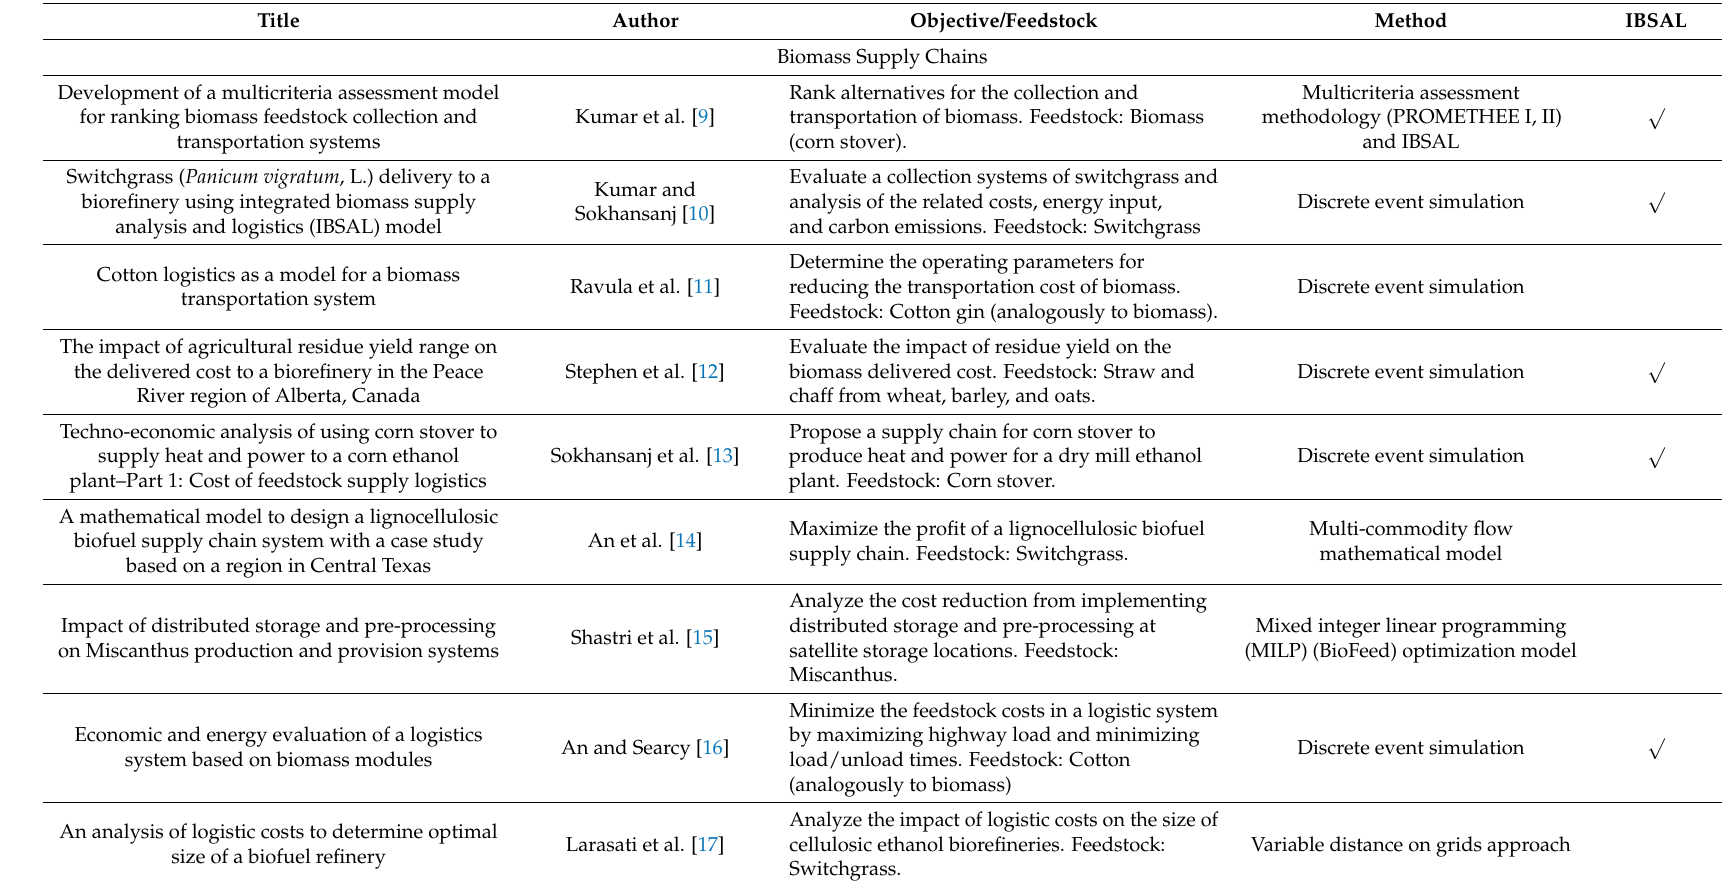
Table 1. Models for biomass